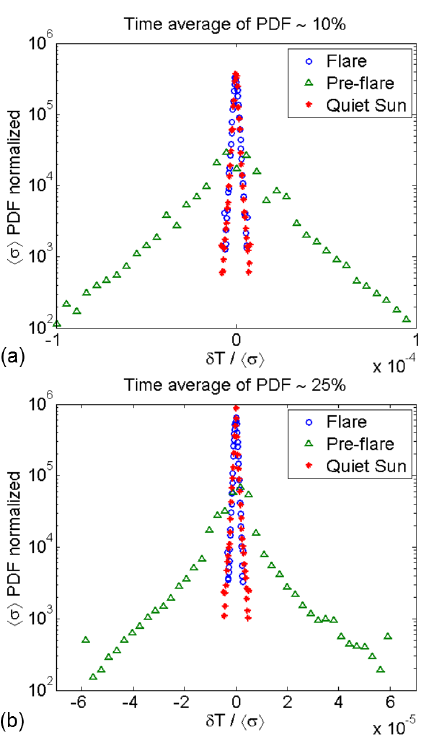
Figure 10. PDF averaged over time frames for energy content in the small scales of (a) 10% (more reconstruction modes) and (b) 25% (fewer reconstruction modes).